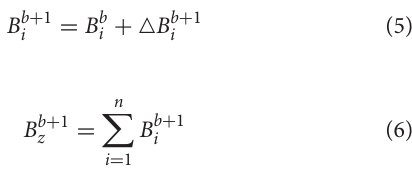
performance of all parks in the zone at the current budget level, and (cid:52) B b 1 is the change in total zone budget for the new budget Z level increment. We then estimated the new total park B i b + 1 and zone budgets B Zb + 1 using Equations (5, 6)